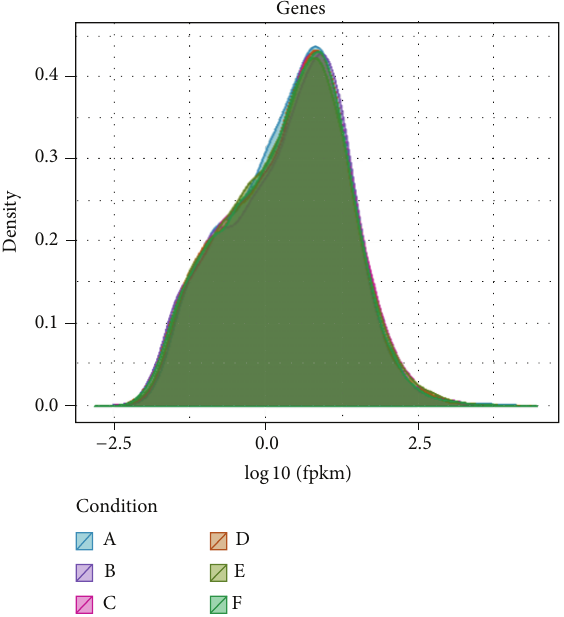
Figure 2: Distributed density of gene global expression of each